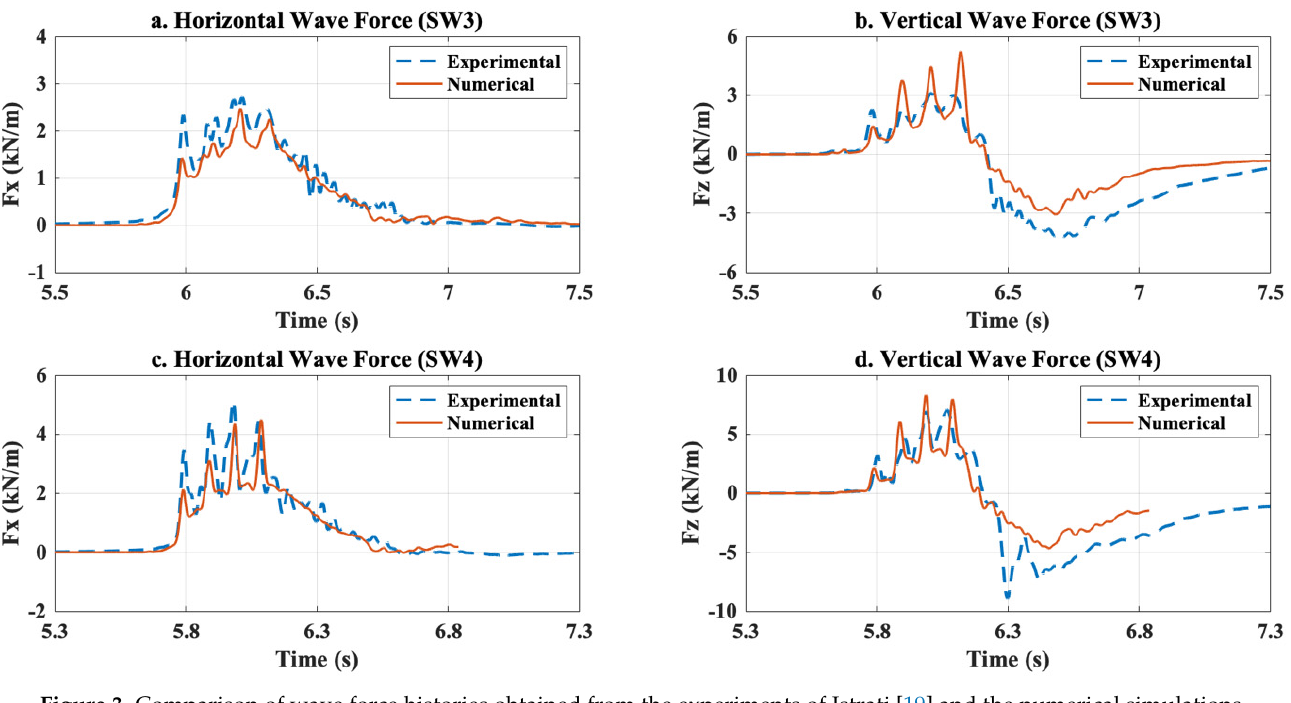
Figure 3. Comparison of wave force histories obtained from the experiments of Istrati [19] and the numerical simulations for SW3 and SW4.